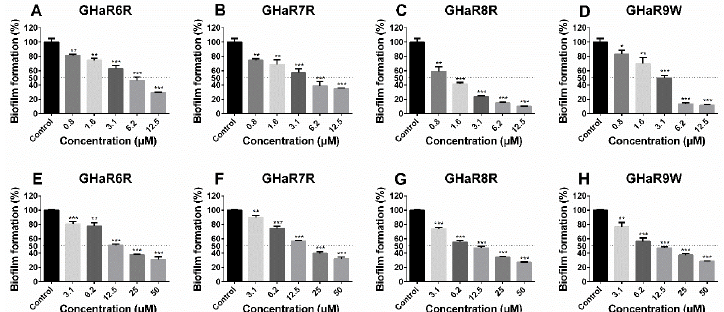
Figure 7. The biofilms formation inhibitory activity of ( A ) GHaR6R, ( B ) GHaR7R, ( C ) GHaR8R, and ( D ) GHaR9W, and the mature biofilms eradication of ( E ) GHaR6R, ( F ) GHaR7R, ( G ) GHaR8R, and ( H ) GHaR9W. The biofilms were stained by CV, and the absorbance was monitored at 590 nm. (* p < 0.05, ** p < 0.01, *** p < 0.001). The biofilms untreated with the peptides were used as the negative control. The dashed lines represented 50% of the biofilm